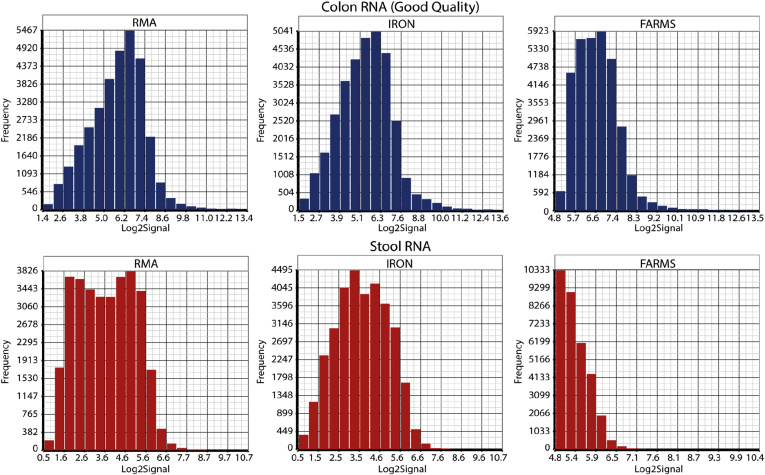
A comparison of transcript signal intensity and the transcript frequency in samples from colon biopsies and fecal samples. Note that the distributions of transcripts at a given intensity are similar between both types of samples using 3 different normalization methods, suggesting that these fecal samples are adequate for analyses.